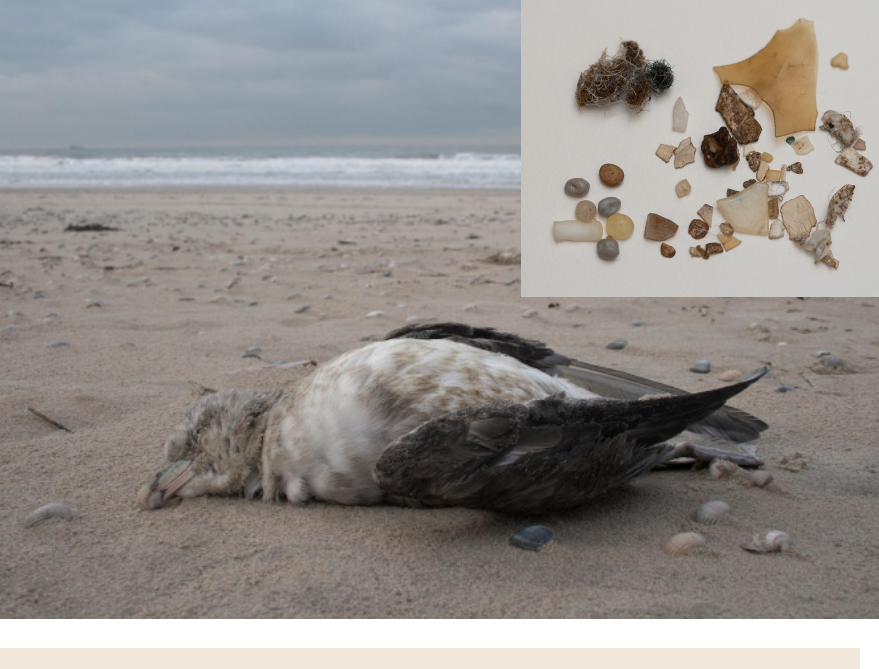
Image: Beached fulmar © JA van Franeker Inset: Plastics from a fulmar stomach © JA van